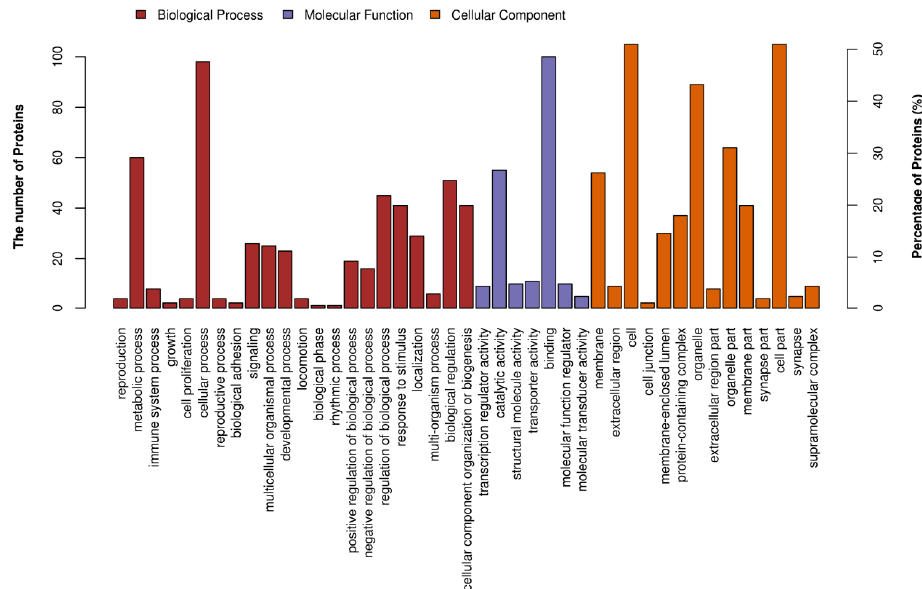
Figure 8. Gene ontology (GO) analysis of total proteins based on the categories cellular component, biological process and molecular function.